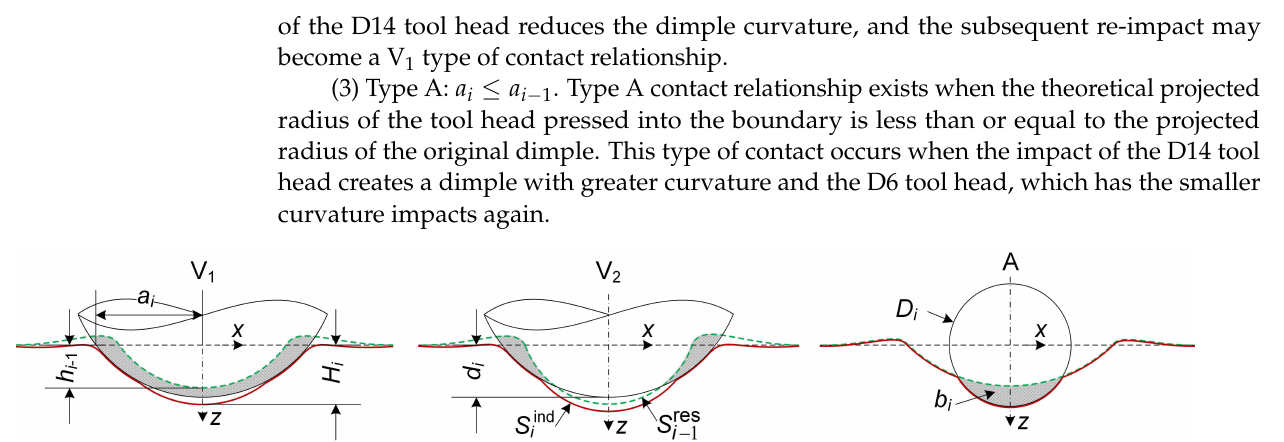
Figure 4. Contact relations between hammering tool and original dimple.